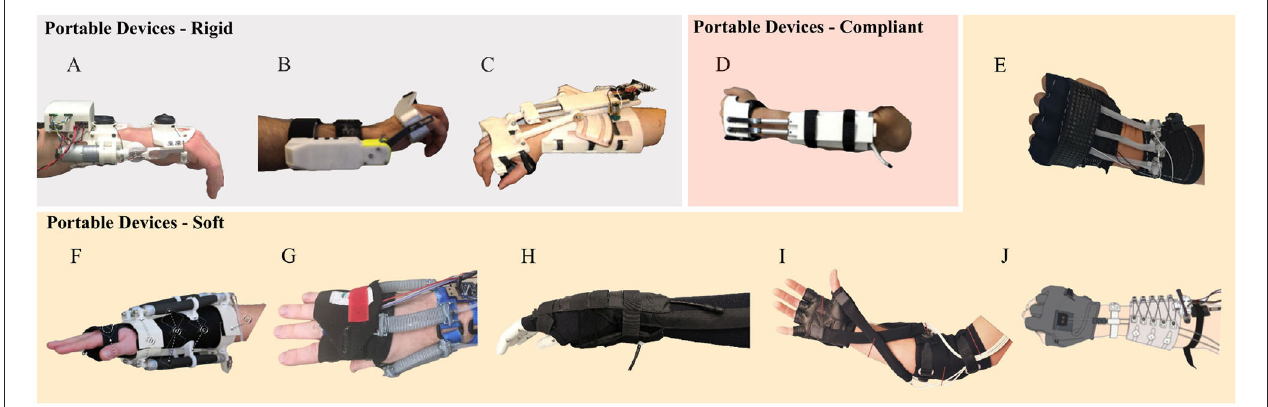
FIGURE 1 | State of the art of portable wrist exoskeletons can be grouped in rigid (A–C) , compliant (D) , or made of soft materials (E–J) . Main intended use of portable exoskeletons are rehabilitation and